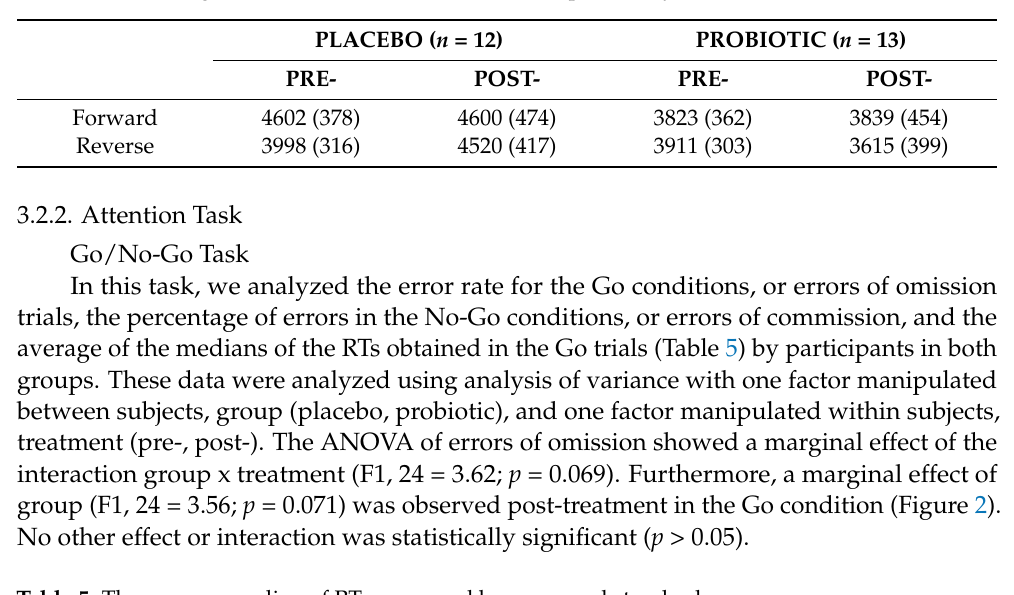
Table 4. The average median of Reaction Times (RTs) expressed by mean and standard error.